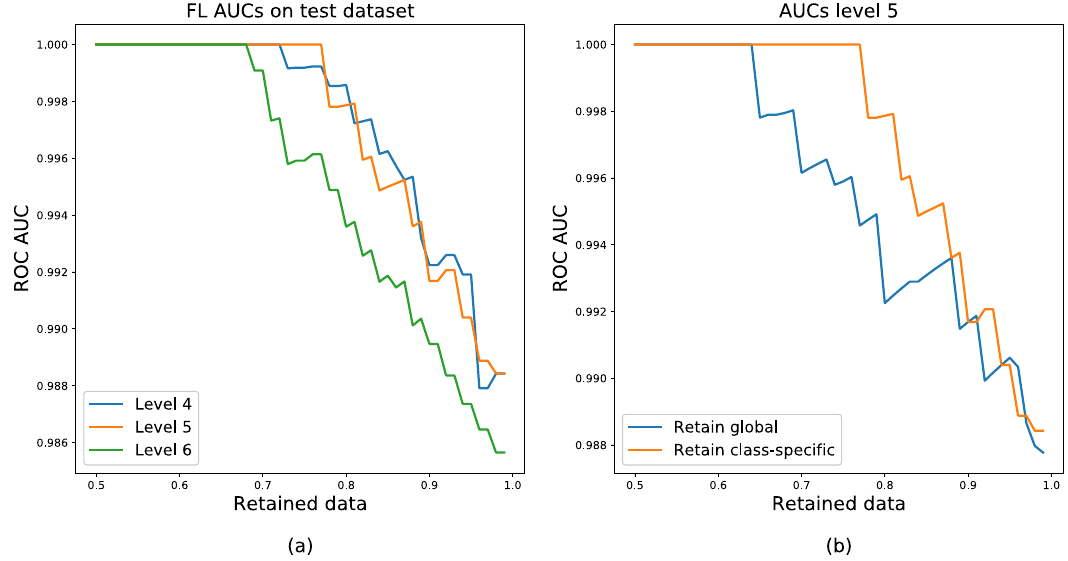
Fig. 5 Improvement of Receiver-Operating Characteristics (ROC) via uncertain data removal. a ROC-Area under the curve (AUC) increases with uncertain data removal at different resolutions. b In the model trained at 15.68 µm/pixel (level 5), removing uncertain slides increases other slide diagnosis performance. Class-speci fi c uncertainty thresholding (orange curve) appears to be superior to global uncertainty thresholding (blue curve) due to differences in FL/FH uncertainty distributions.